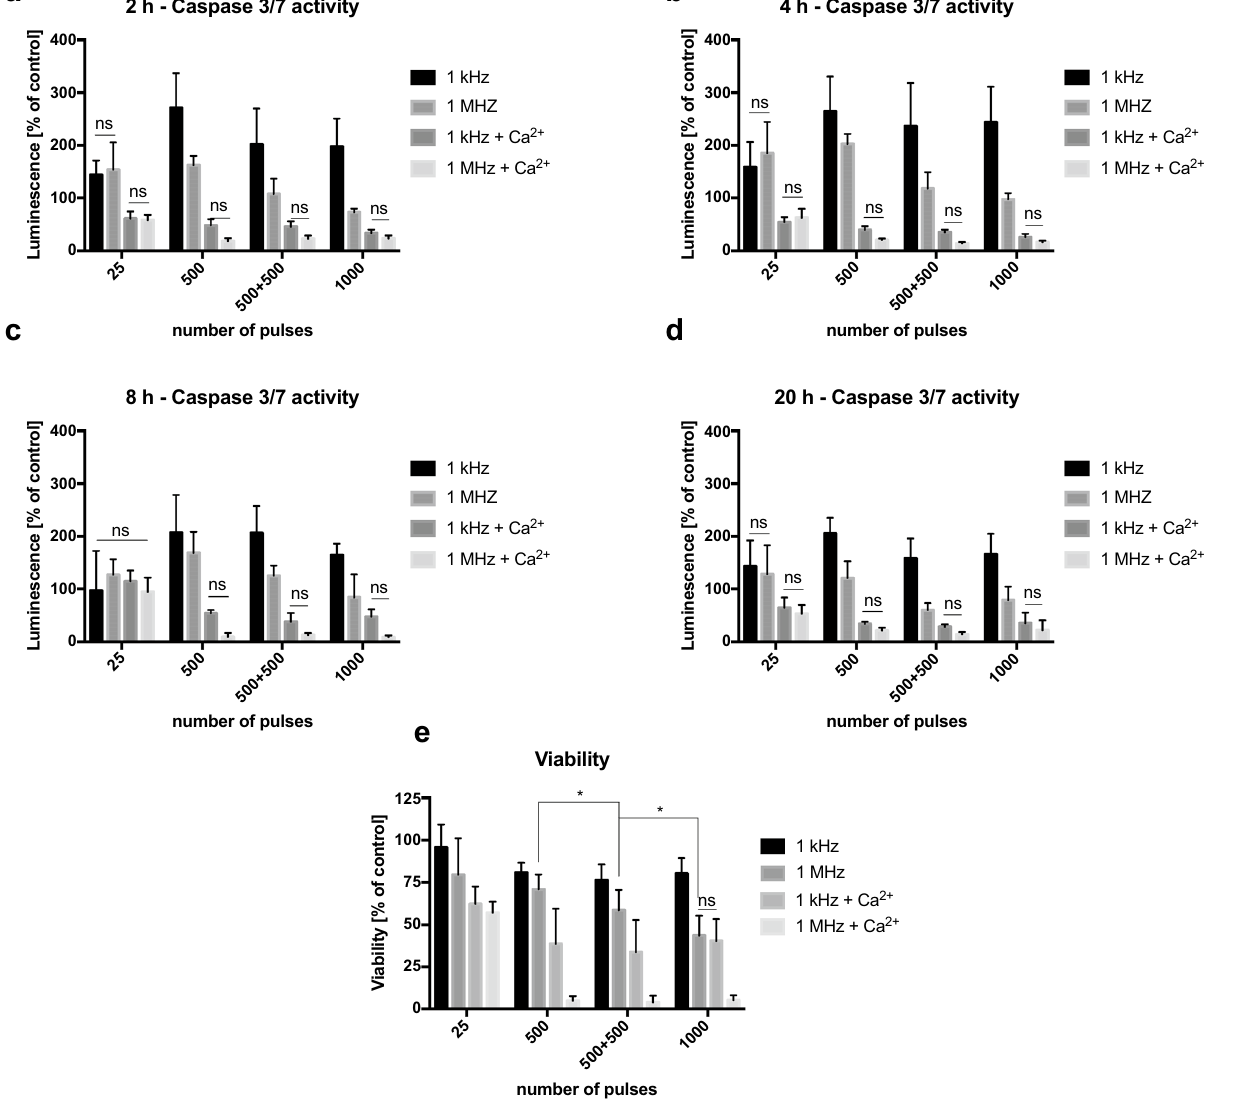
Figure 3. Viability and Caspase 3/7 activity of the DU 145 cells after high-frequency PEFs application. Cells were exposed in suspension in a 1-mm gap electroporation cuvette (200 ns duration, 10 kV). ( e ) The effect of pulse number in two different frequencies and different extracellular calcium concentration. The viability was assessed with MTT assay 24 h after PEFs expousure. ( a – d ) The Caspase 3/7 activity in the cells after exposure to a different number of PEFs in two frequencies and different extracellular Ca 2+ concentration. The caspase 3/7 activity was determined with Caspase-Glo 3/7 Assay from Promega 2, 4, 8 and 20 h after elctroporation. Graphs are representative of at least 3 independent experiments. Data are mean ± SD (n = 3–4 independent experiments). (ns) indicates no statistically significant difference between the pair of samples (*) indicates statistically significant differences between the pair of samples (ANOVA, p <